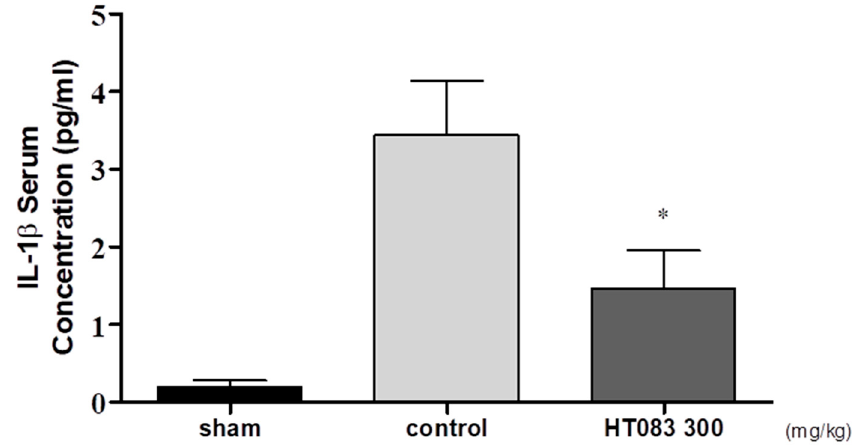
Figure 4. The change of serum IL-1 β concentration in MIA rats after HT083 treatment. Each value is the mean ± SEM. The number of animals is nine per group; * p < 0.05, * p < 0.01 and * p < 0.001 vs. control (one-way ANOVA, Dunnett's post hoc test).